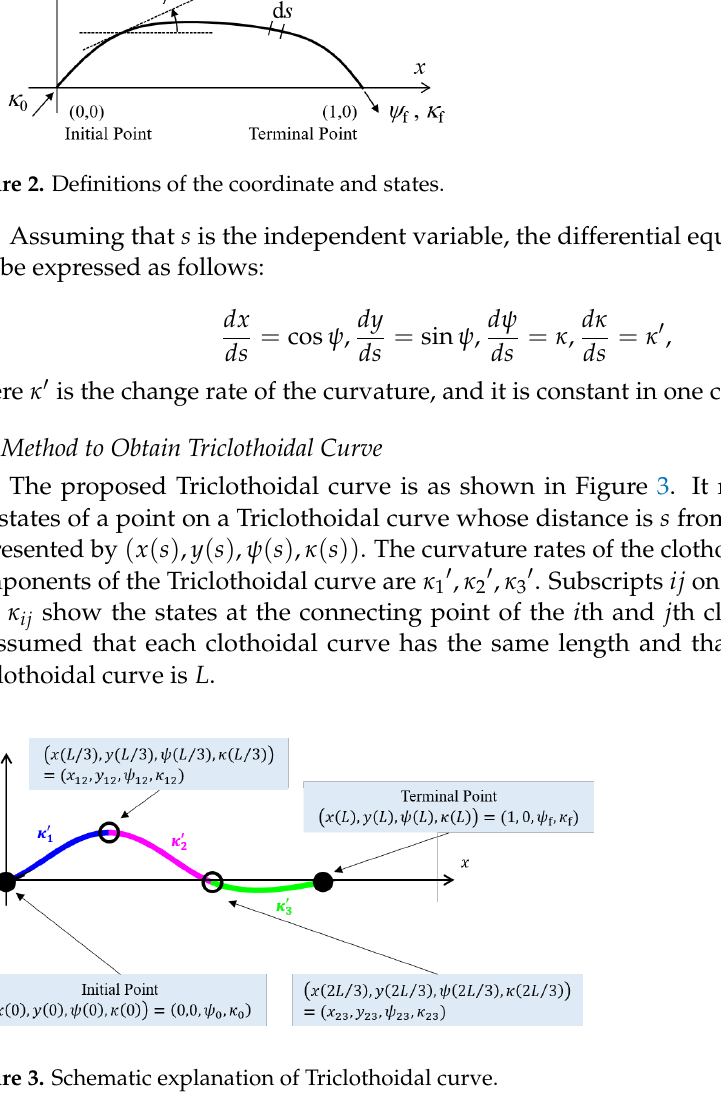
Figure 3. Schematic explanation of Triclothoidal